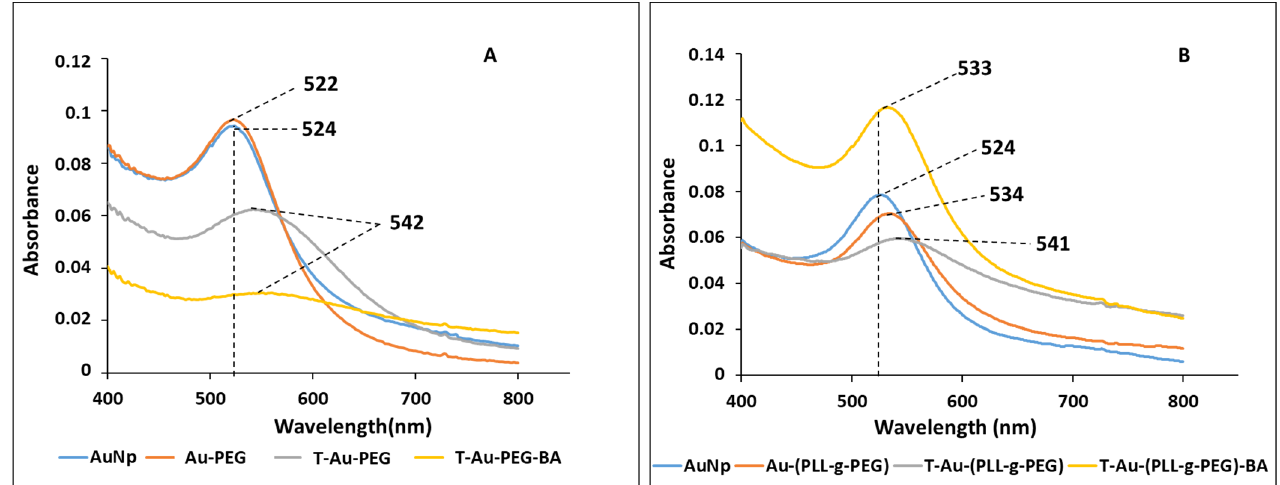
Figure 2. UV-vis of nanoparticles and drug nanocomplexes showing changes in surface plasmon resonance: ( A ) PEG functionalized AuNPs; ( B ) PLL-g-PEG coated AuNPs.